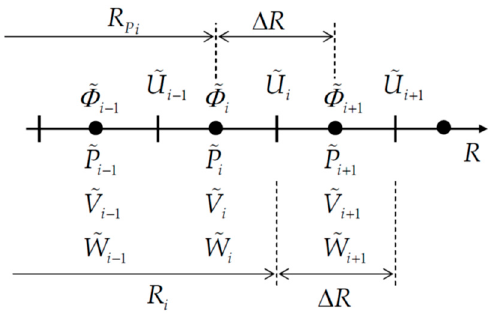
Figure 5. The one-dimensional equidistant staggered grid system for analyzing the disturbance equations.